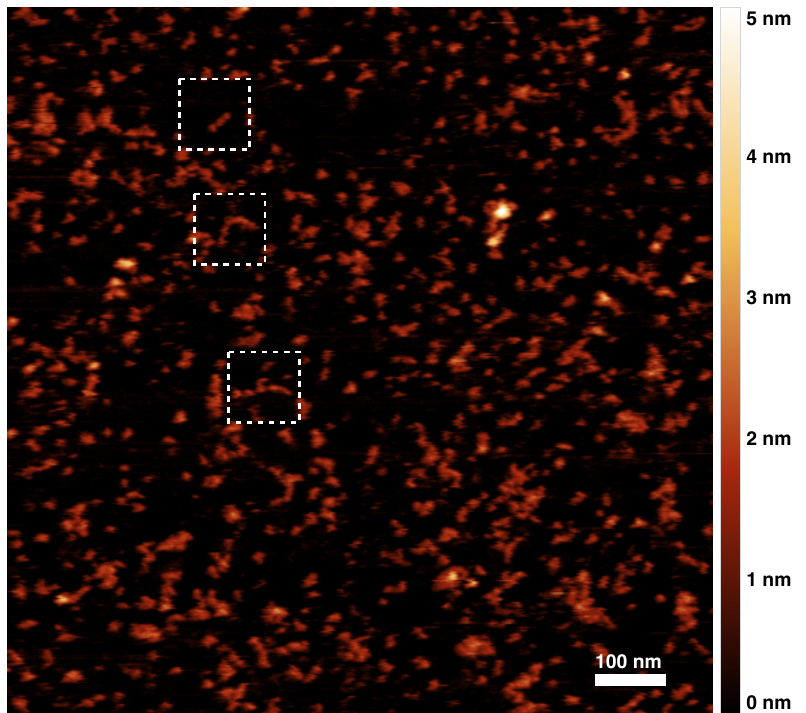
Figure 1. AFM image of a sample comprising Z α 1 AT monomers and polymers; the colored scale on the right indicates the height of the pictured objects and the dashed squares show 100 nm × 100 nm regions of interest analysed in Figure